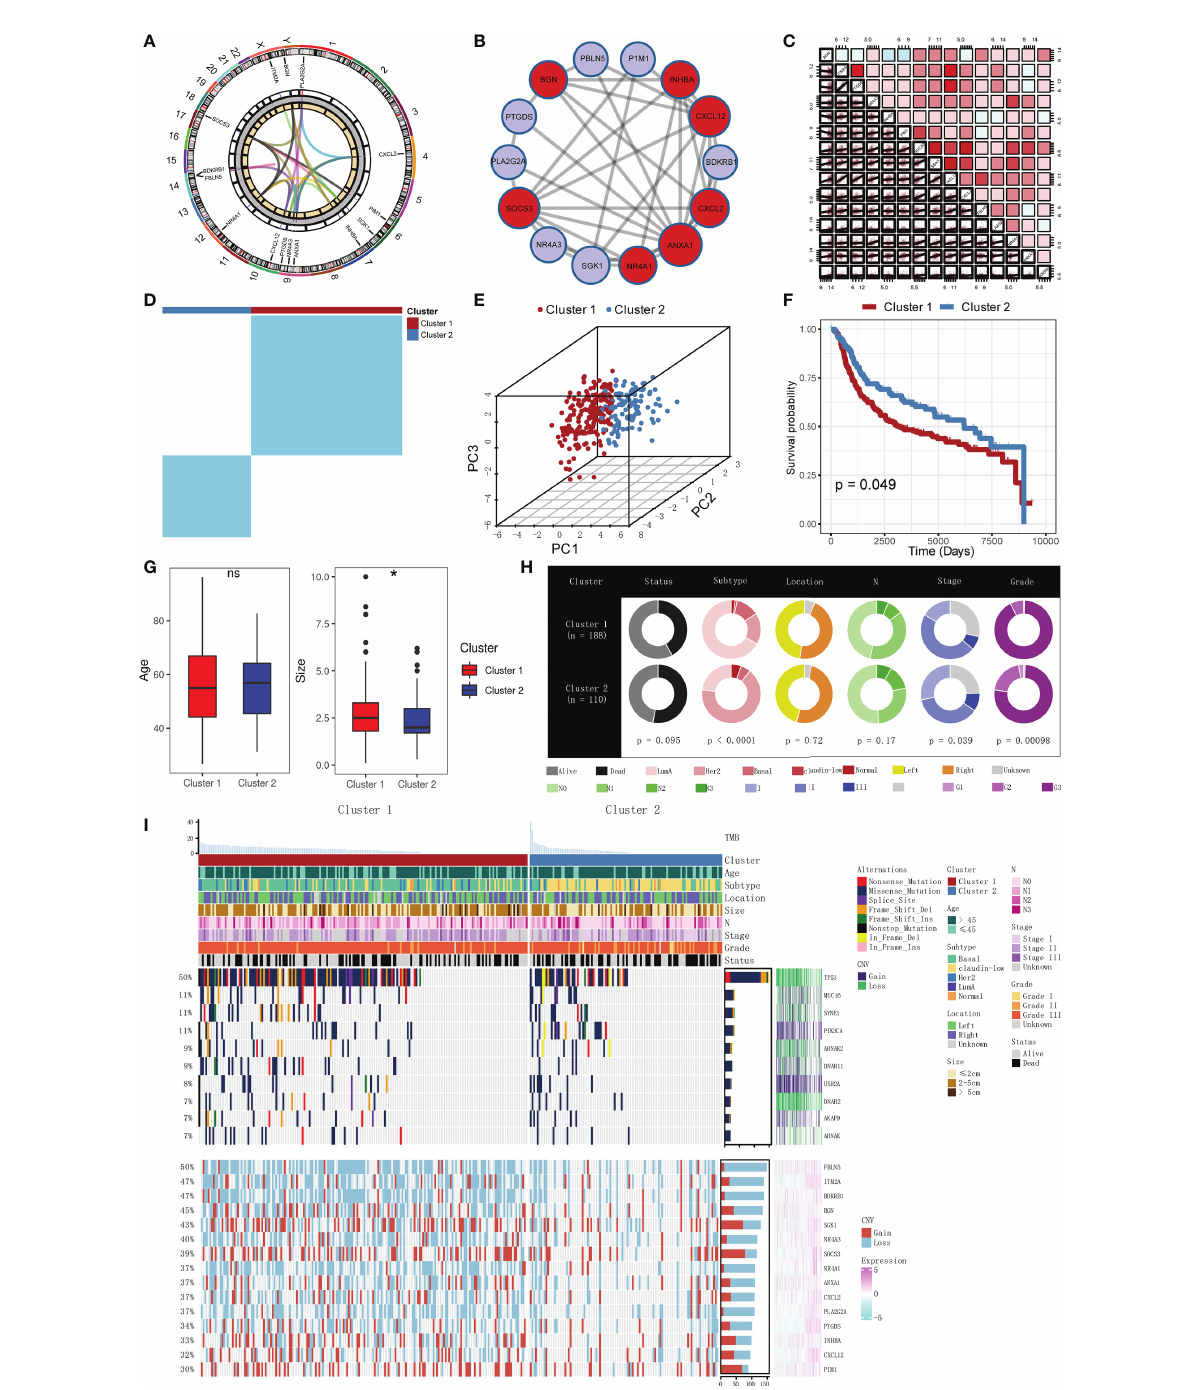
FIGURE 2 General recognition and unsupervised clustering of the CAF-related genes, and relationships between clusters with prognosis and clinical features. (A) Locations, expression levels, and links of the CAF-related genes on 23 chromosomes. (B) PPI network of the CAF-related genes. Different colors represent different clusters. (C) Correlations of each CAF-related gene (red: positive correlation; sky blue: negative correlation). (D) Unsupervised clustering based on the CAF-related genes in the METABRIC cohort (k = 2). (E) PCA analysis of two clusters ( fi rebrick: cluster 1; steel blue: cluster 2). (F) K-M survival analysis of two clusters ( fi rebrick: cluster 1; steel blue: cluster 2). (G) Boxplots of two clusters with age and tumor sizes ( fi rebrick: cluster 1; steel blue: cluster 2; ns means no signi fi cance, and * means p < 0.05). (H) Doughnut diagrams of two clusters in survival status, PAM50 subtype, pathologic location, pathologic N, clinical stage, and pathologic grade. (I) Muti-omics landscape of samples in two